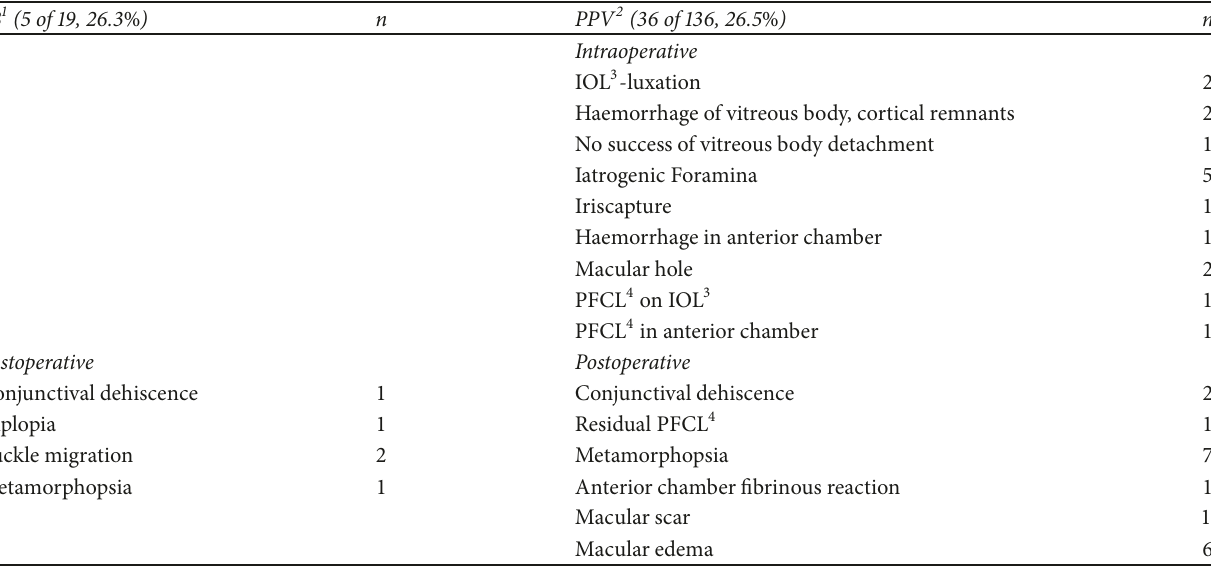
Table 1: Intra- and/or postoperative complications of SB versus